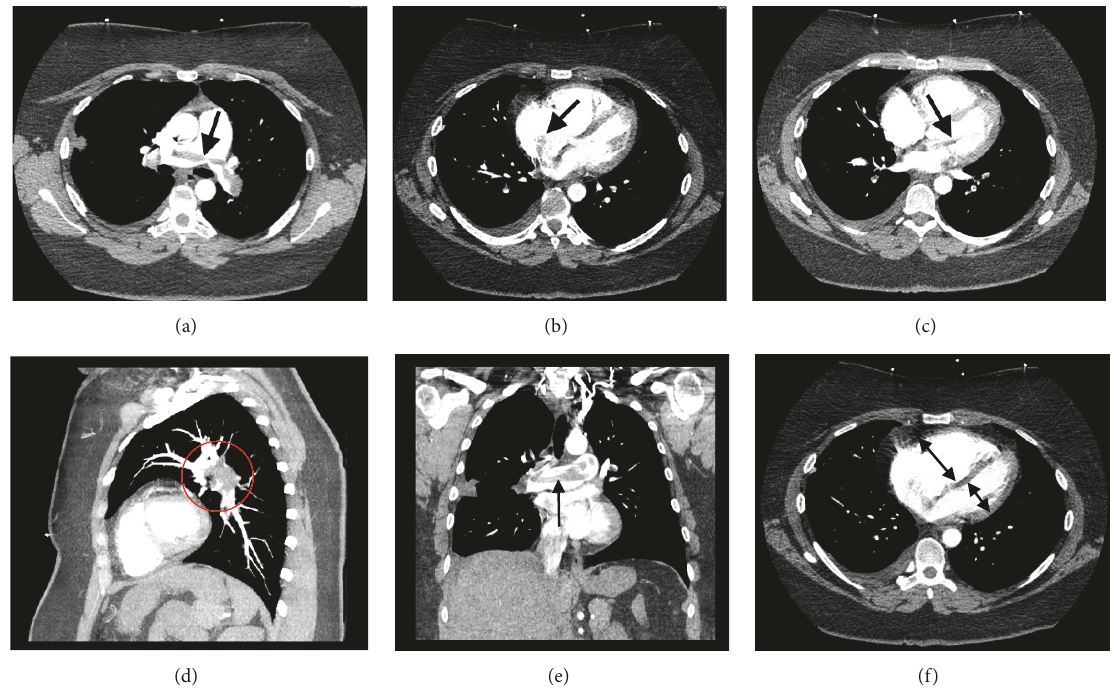
Figure 2: CTPA showing saddle PE (a), intracardiac thrombus extending from RA to LA through PFO (b) and further prolapsing into the left ventricle through mitral valve leaflets (c): all axial reconstruction. The same clot in sagittal view ((d), inside the red circle) and coronal view (e). RV enlargement relative to LV compressing the LV in characteristic “D shaped” pattern ((f), double arrows) all consistent with RV